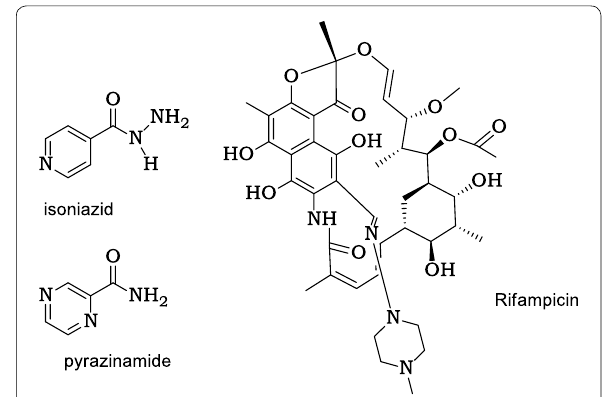
Fig. 1 Currently available anti-tubercular drugs containing amide